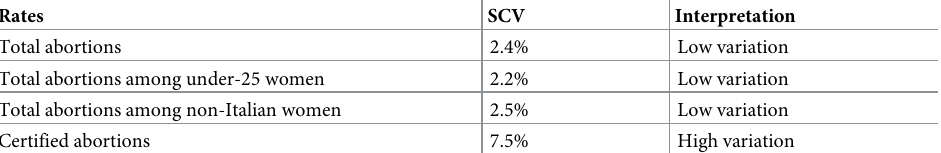
The Systematic Component of Variation (SCV) was expressed as a percentage. The SCV is a method of standardization in which age grouping (five-year age grouping in our study) is assumed to change the risk of abortion by a fixed multiplicative factor. The SCV estimates the relative systematic component of variation between health districts by subtracting the random component of variance (variance within districts) from the estimate of the total variance. Therefore, the SCV represents the systematic variation considered to be beyond chance, thus being